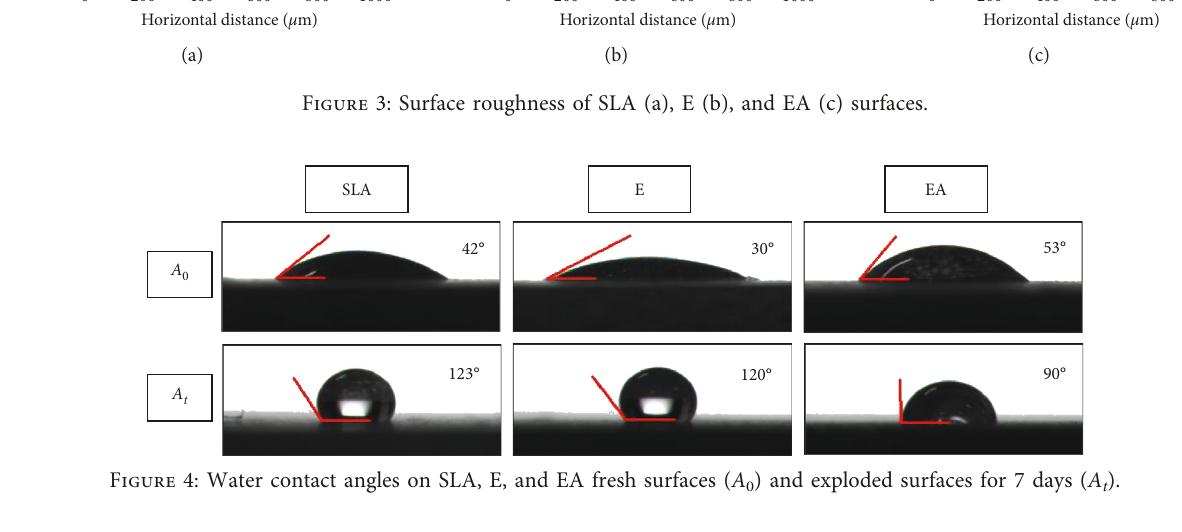
0 ) and exploded surfaces for 7 days ( A t ).